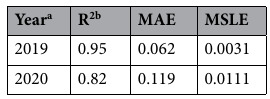
respectively, whereas soil temperature averaged 16.6 °C. These observations in 2019 align with the findings of Kaminski and Dernoeden 9 who recorded P. annua emergence in cool-season turfgrass once air temperatures fell to 20 °C. Additionally, McElroy et al. 8 reported that the optimal air temperature for P. annua germination in